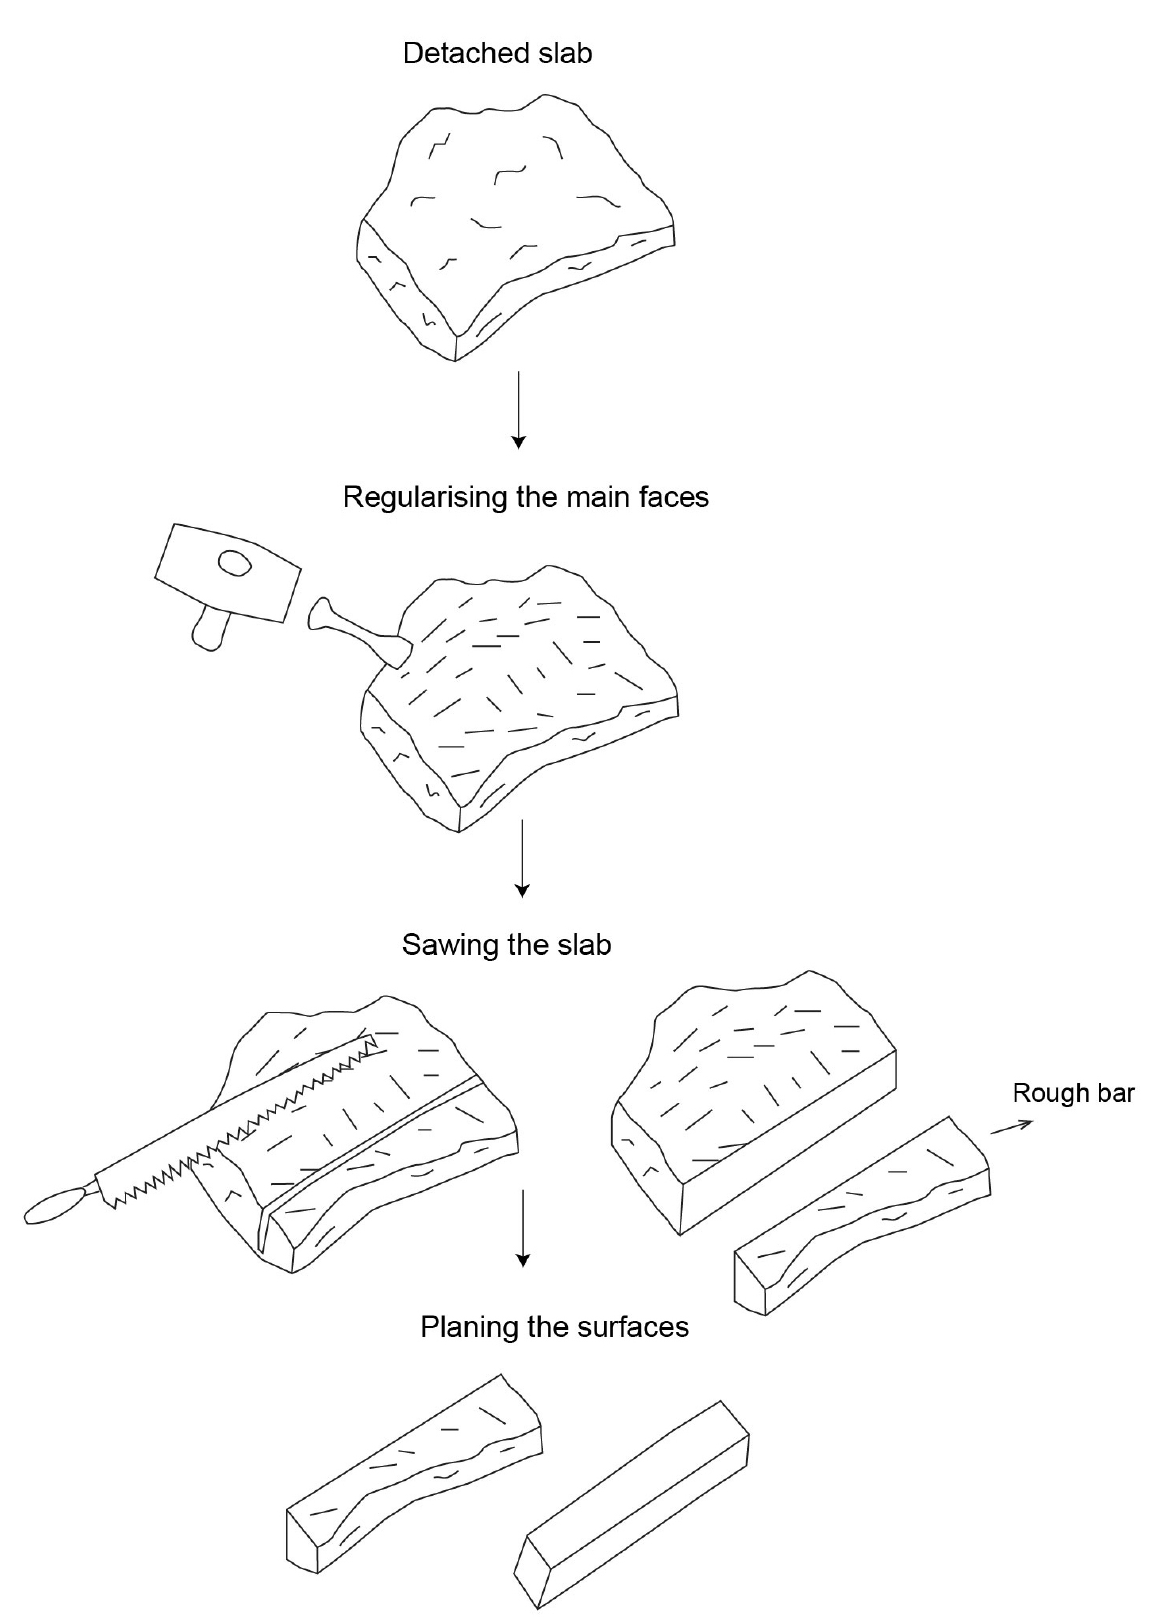
Figure 5: Reconstruction of the whetstone production sequence at the Nereth